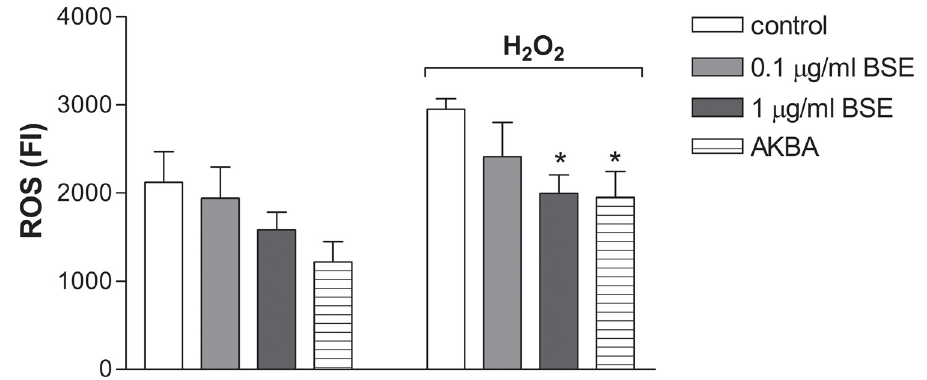
Fig 8. Effect of BSE and AKBA on ROS level in Caco-2 cells. ROS were measured after 24 hours of incubation in untreated cells and after 500 μ M H 2 O 2 exposure. Data are expressed as mean ± SEM percentage of basal (100%) DCF fluorescence intensity (FI) of n = 4 experiments. * p < 0.05 BSE or AKBA vs H 2 O 2 .